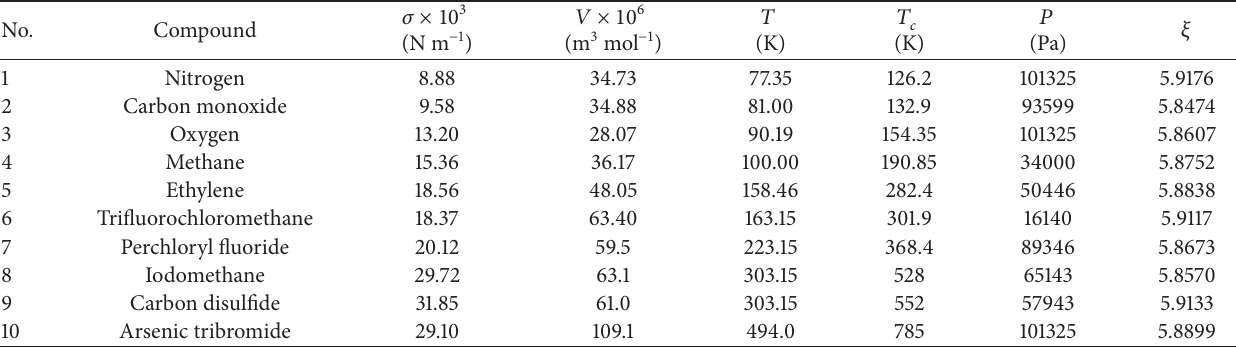
Table 2: Towards the evaluation of the constant 𝜉